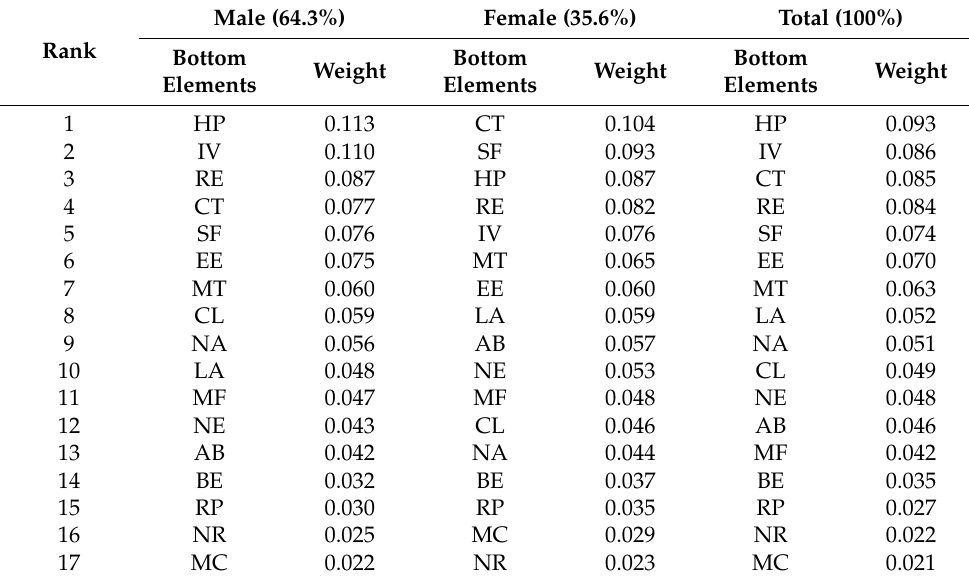
Table 7. The AHP Analysis of Gender Preference.